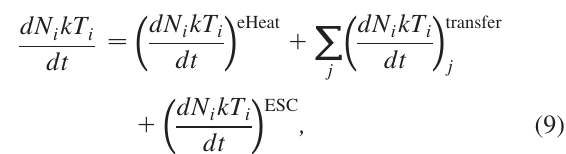
FIG. 2. Diagram indicating the main couplings considered effecting the change of numbers of trapped species (horizontal or curved arrows) and energy (vertical arrows). The definitions for the abbreviations RR, DR, EI, and CX are given in the main text. Each charge state is also energetically coupled to all the others through ion-ion collisions although this coupling has been omitted for clarity.